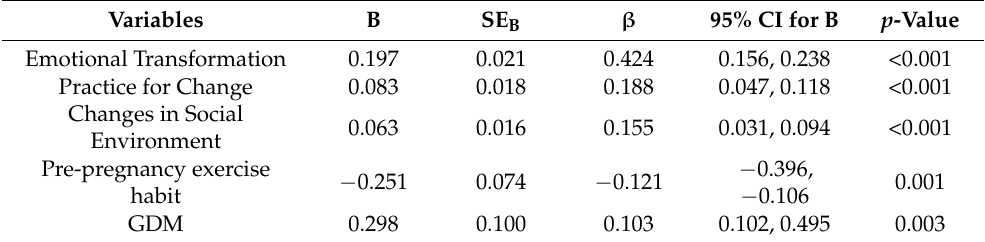
Table 6. Multiple Regression Model of intention to maintain PA Behavior ( n = 450). Variables B SE B β Emotional Transformation